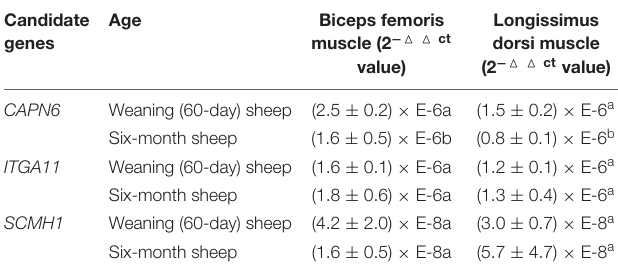
TABLE 5 | Detection of candidate genes at different ages.